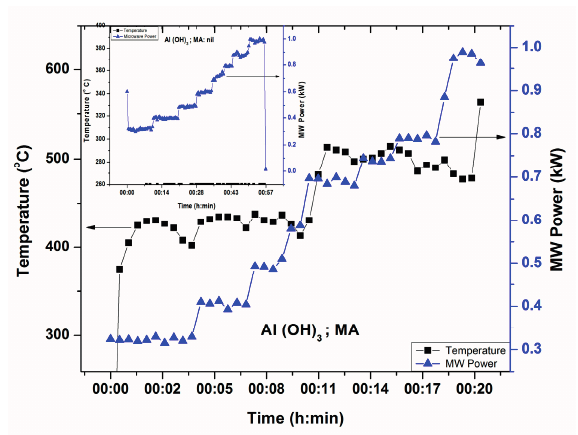
Figure 6. T-P-t profile of Al(OH) 3 in presence of microwave susceptor. Inset shows no temperature increase within 1 h with maximum MW power 1.0 kW in the absence of microwave susceptor.